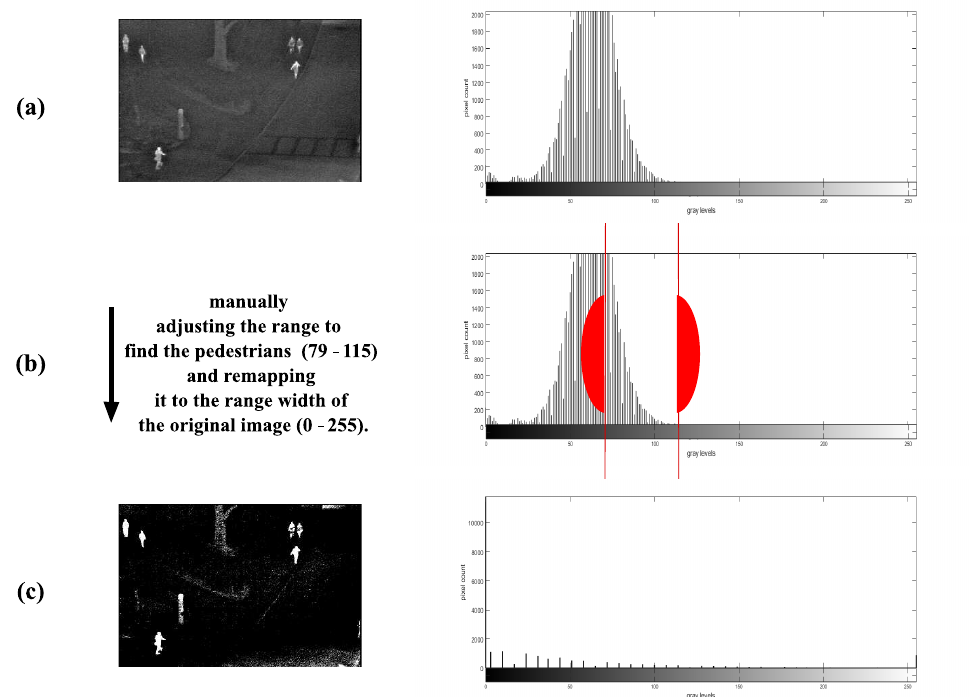
Figure 2. An example of manually adjusting the image to find the range of humans. ( a ) shows the original image and its histogram, and ( b ) shows the manually chosen range, which is between the two red lines (best viewed in colour). ( c ) shows the resulting image and the readjusted